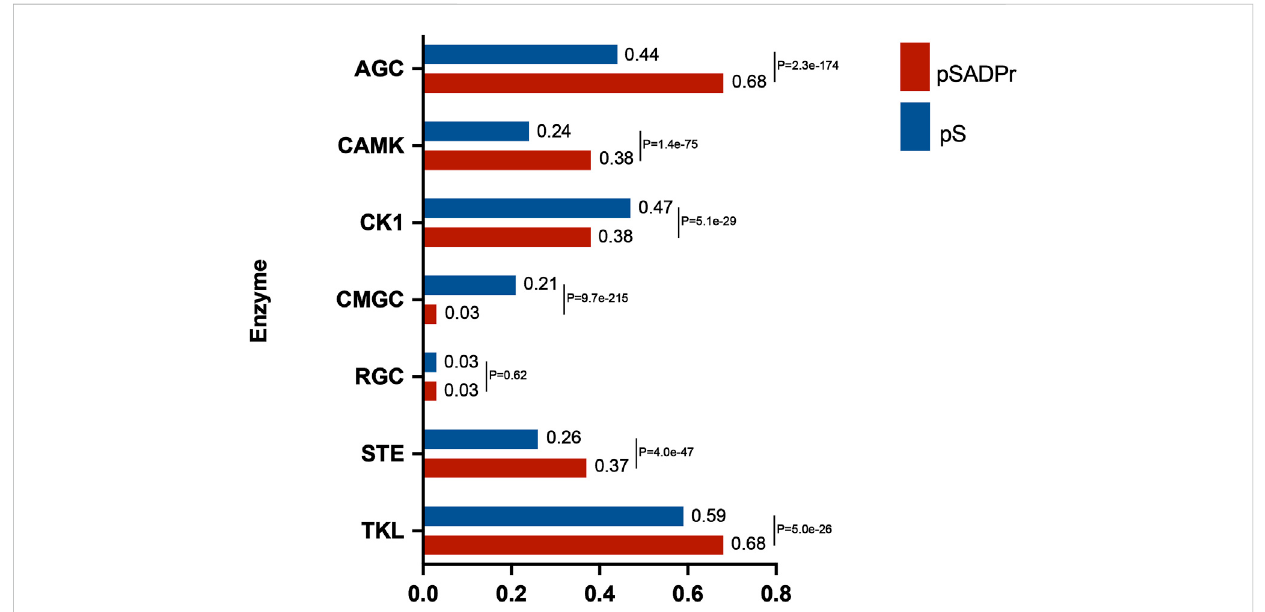
FIGURE 5 Enrichment analysis of human pSADPr sites as the substrates of serine kinase subfamilies predicted by GPS (Wang C. et al., 2020). Human pS sites were used as the background. p -value was calculated using the hyper-geometric test.